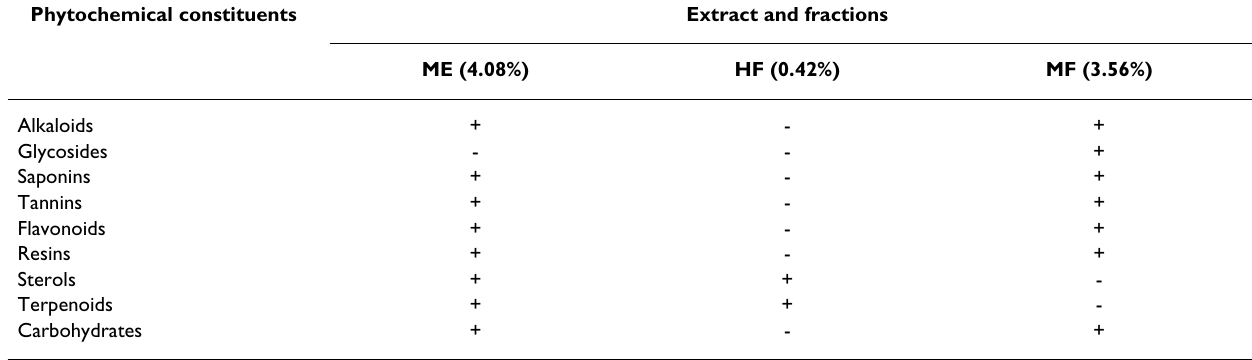
Table 1: Phytochemical constituents of extract and fractions Phytochemical constituents